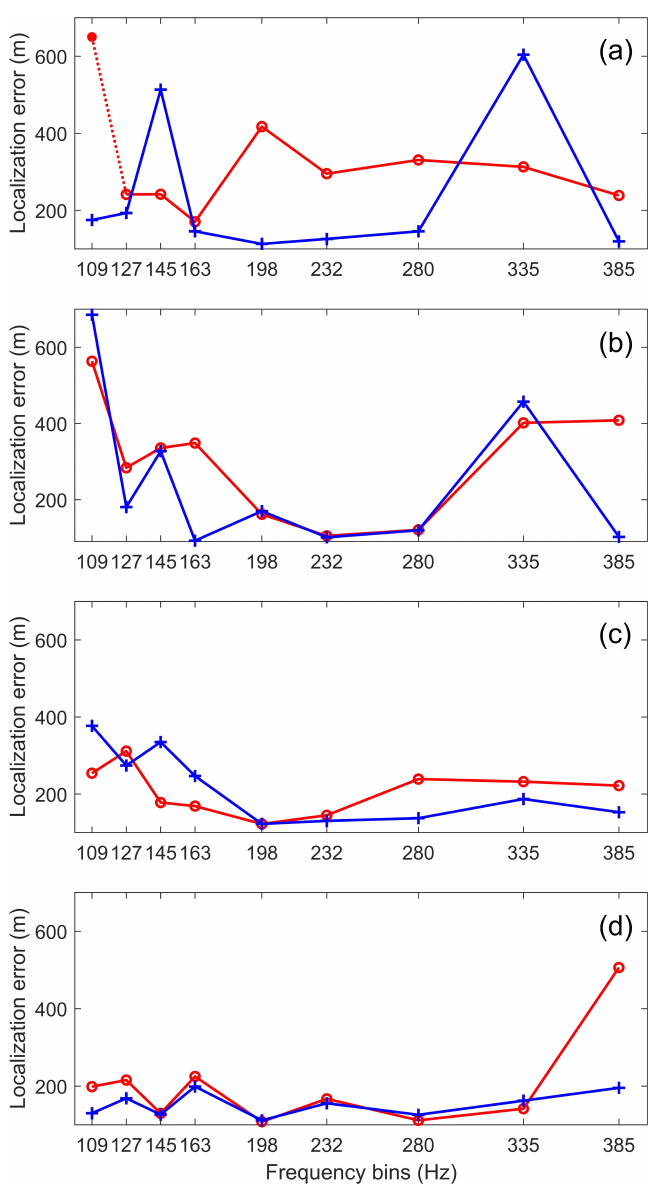
Figure 6. (Color online) Localization errors with nine tone frequencies at ( a ) segment 3, ( b ) segment 4, ( c ) segment 5, and ( d ) 17.5 s past segment 4 of GMA (solid red line with red circles) and N-MUSIC (solid blue line with plus symbols). Note that the estimation error of GMA at segment 3 with 109 Hz is 1681 m and is indicated by the filled circle in ( a